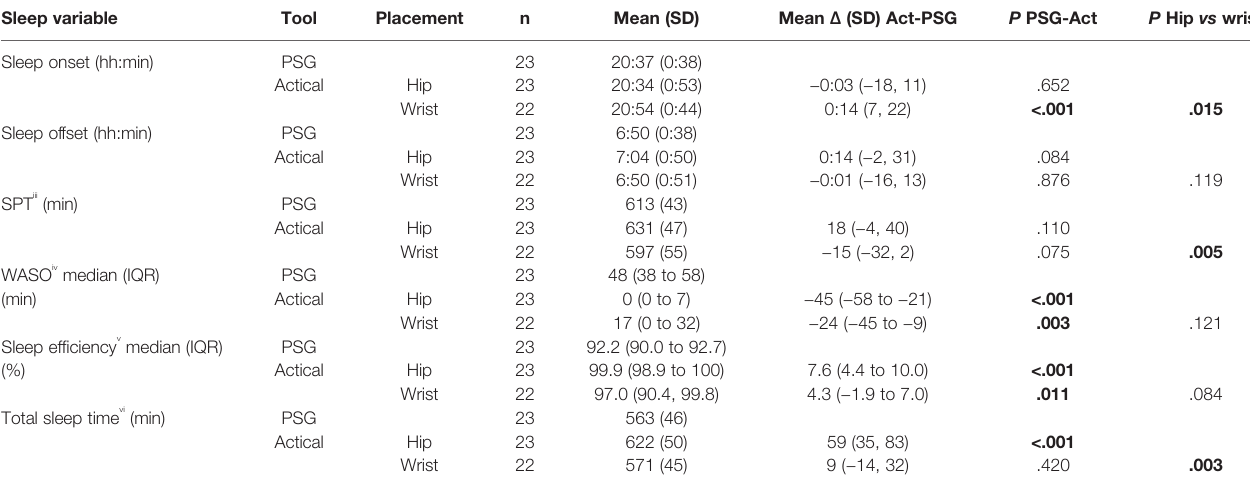
TABLE 4 | Comparison of Actical measured sleep outcomes to PSG and comparison of wrist and hip positioned devices. Sleep variable Tool Placement